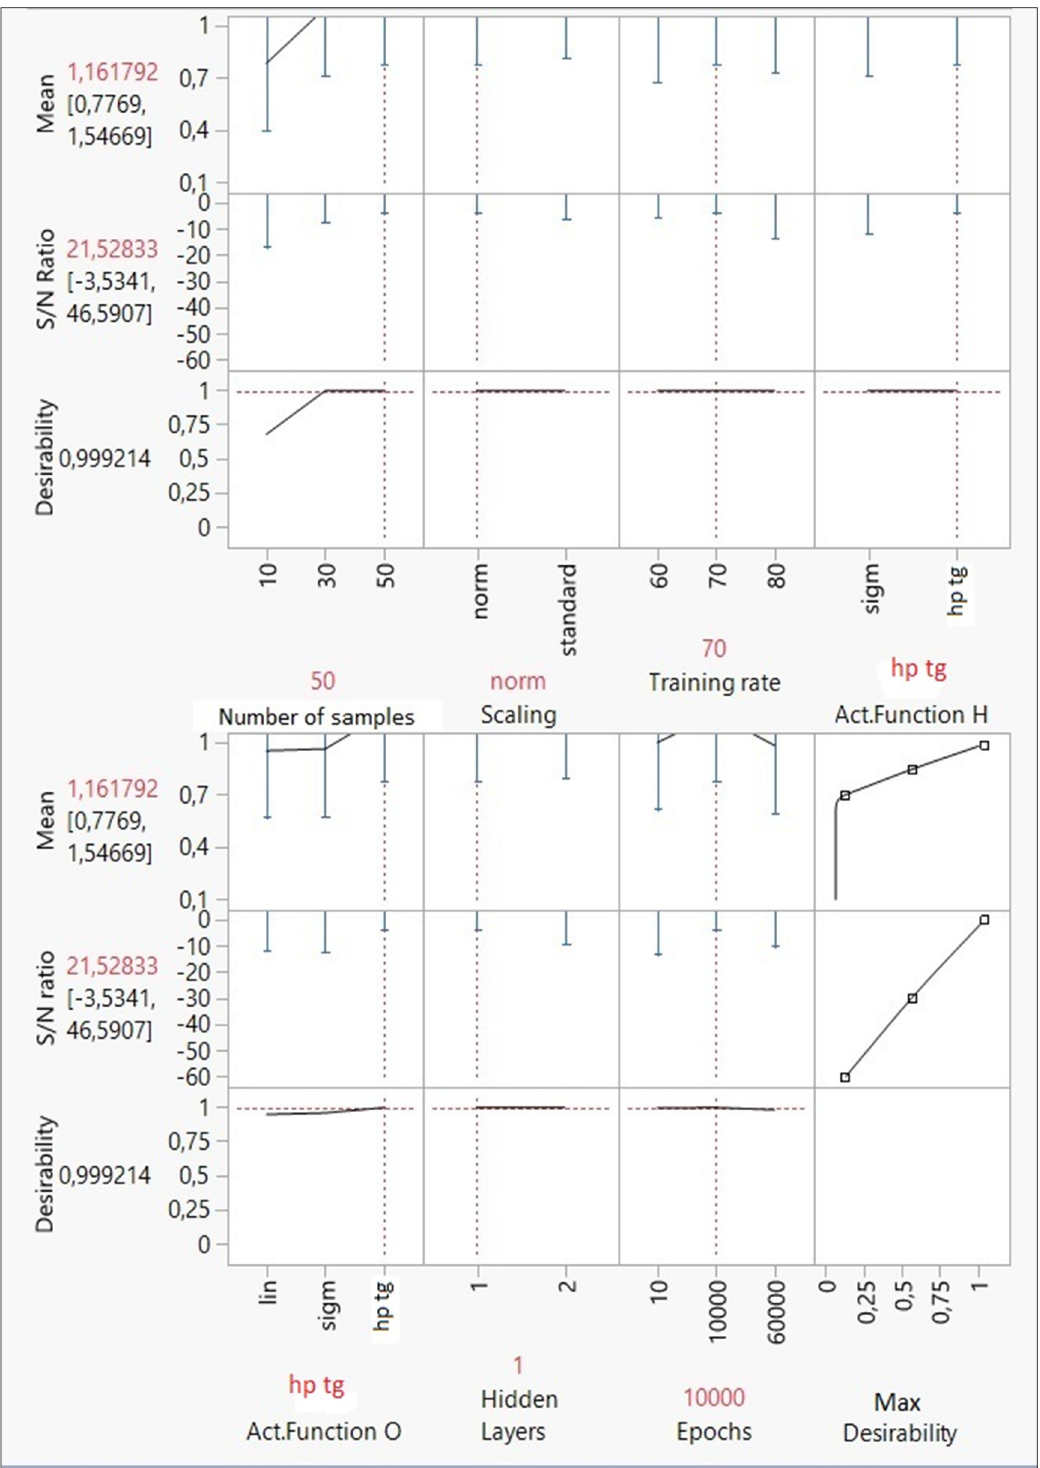
Figure 5. The optimization results according to the desirability function analysis (DFA). Optimal response and factor values are displayed in red. The desirability function is very close to 1 (0.999214), and the tolerance interval for the S/N ratio and mean is [ − 3.54, 46.6] and [0.78, 1.55], respectively. The best architecture’s features set to maximize the predictive capability of the MLP model is shown in the following outline (Table 5).